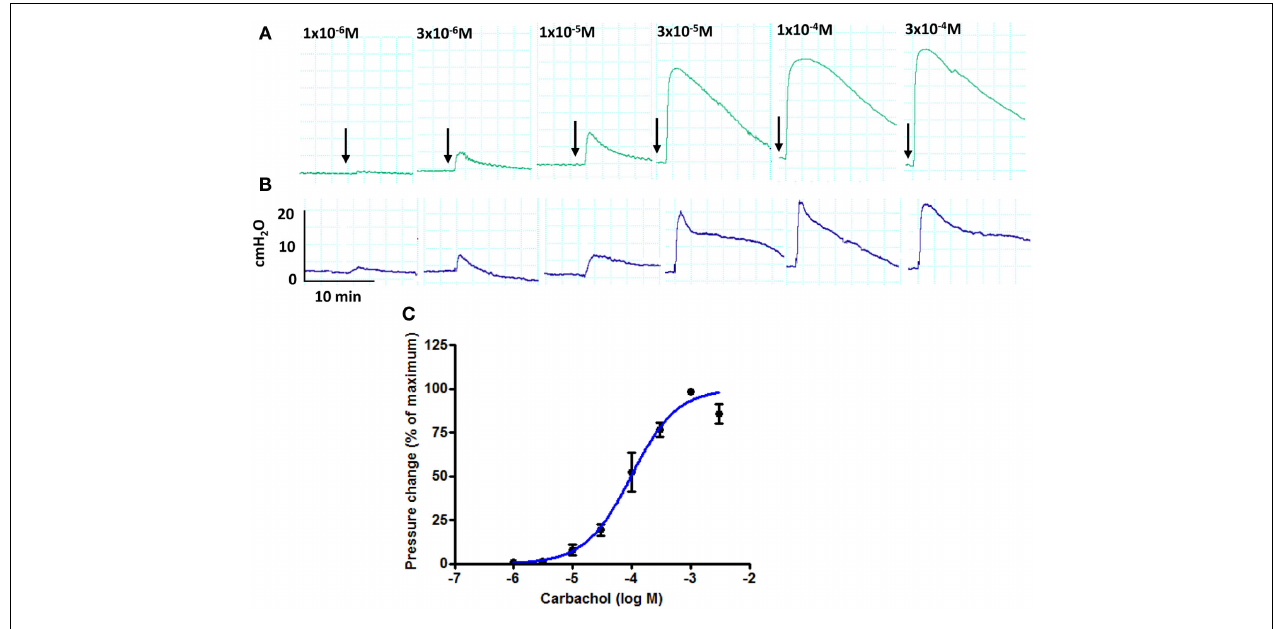
pressure (C) changes to intravesical pressure are expressed as a percentage of the maximum response to carbachol obtained for each bladder ( n = 5).